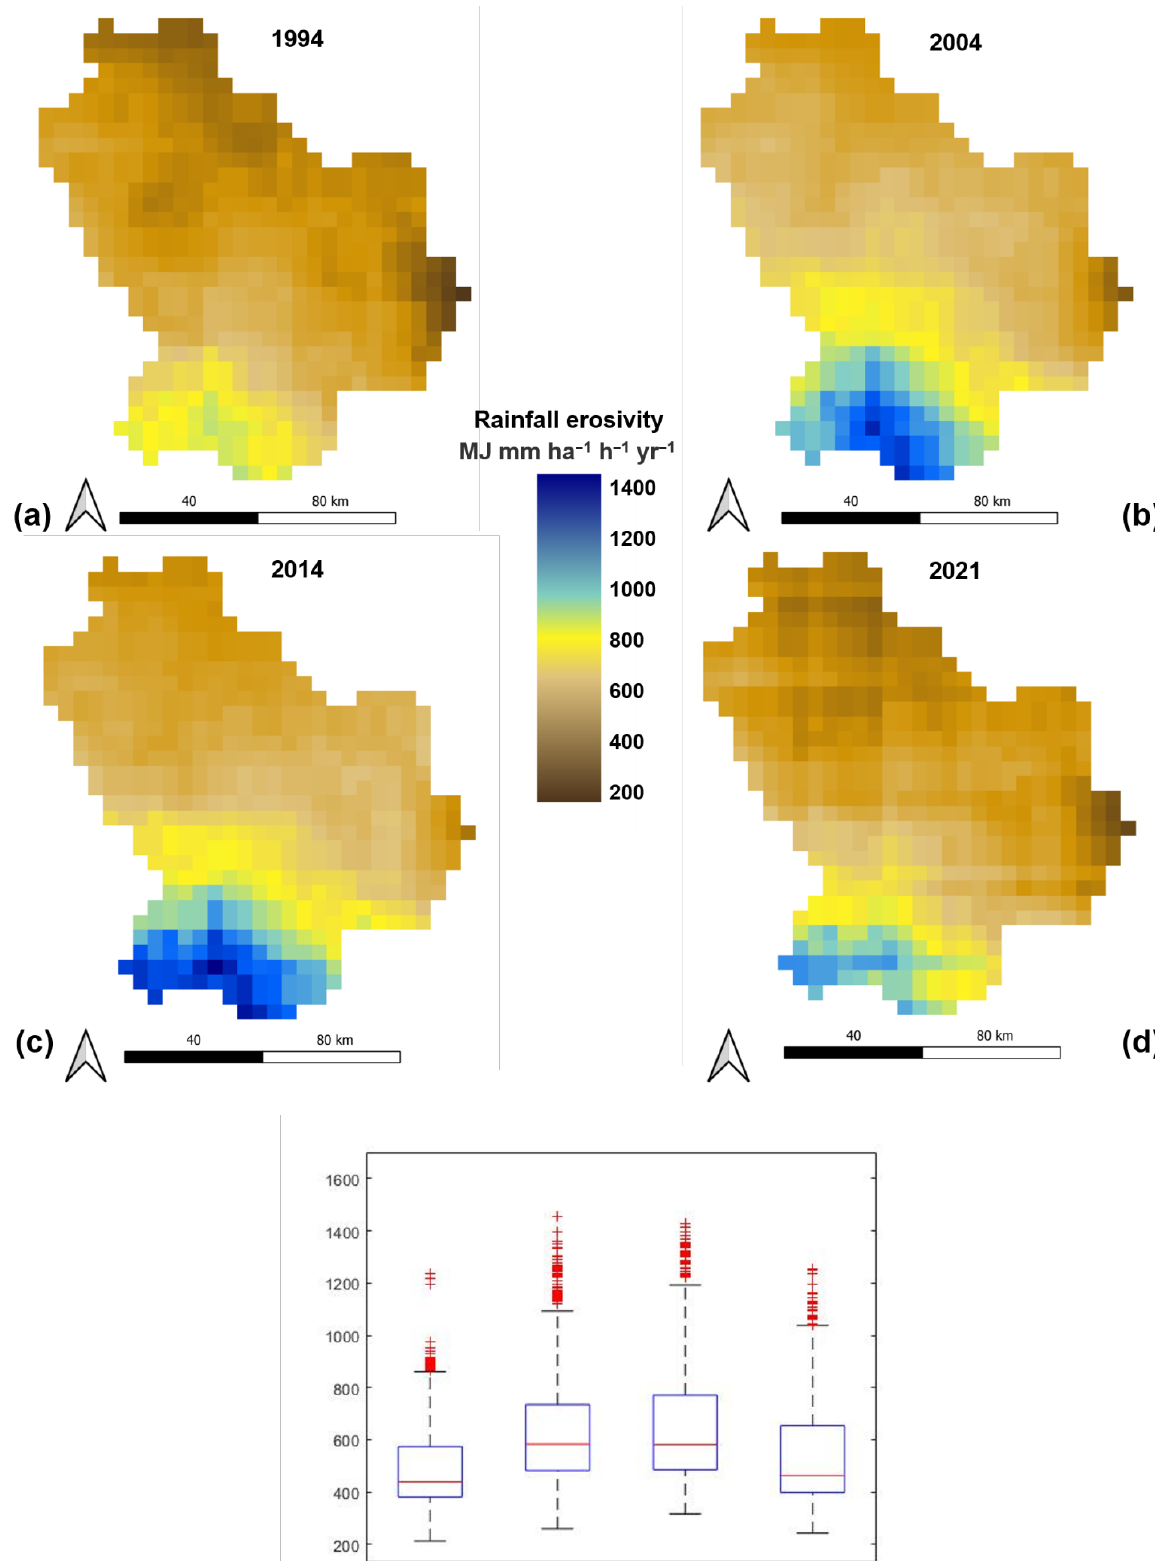
Figure 2. Rainfall erosivity estimations based on CHIRPS data and computed for the four decades preceding: ( a ) 1994; ( b ) 2004; ( c ) 2014; ( d ) 2021; ( e ) boxplots of the R-values.